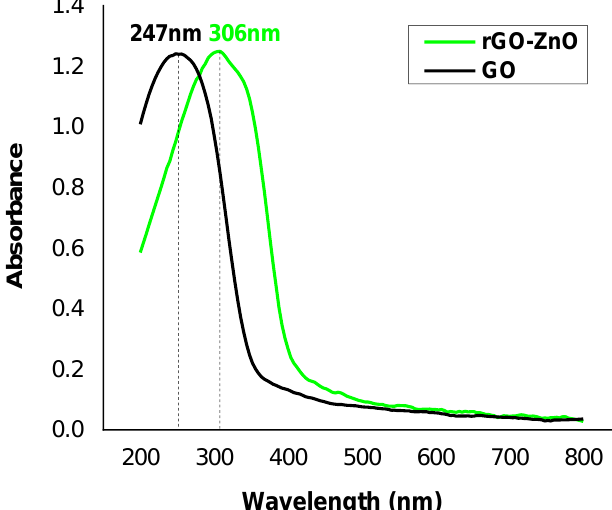
Figure 4. The UV-Vis spectral study of adsorbents.